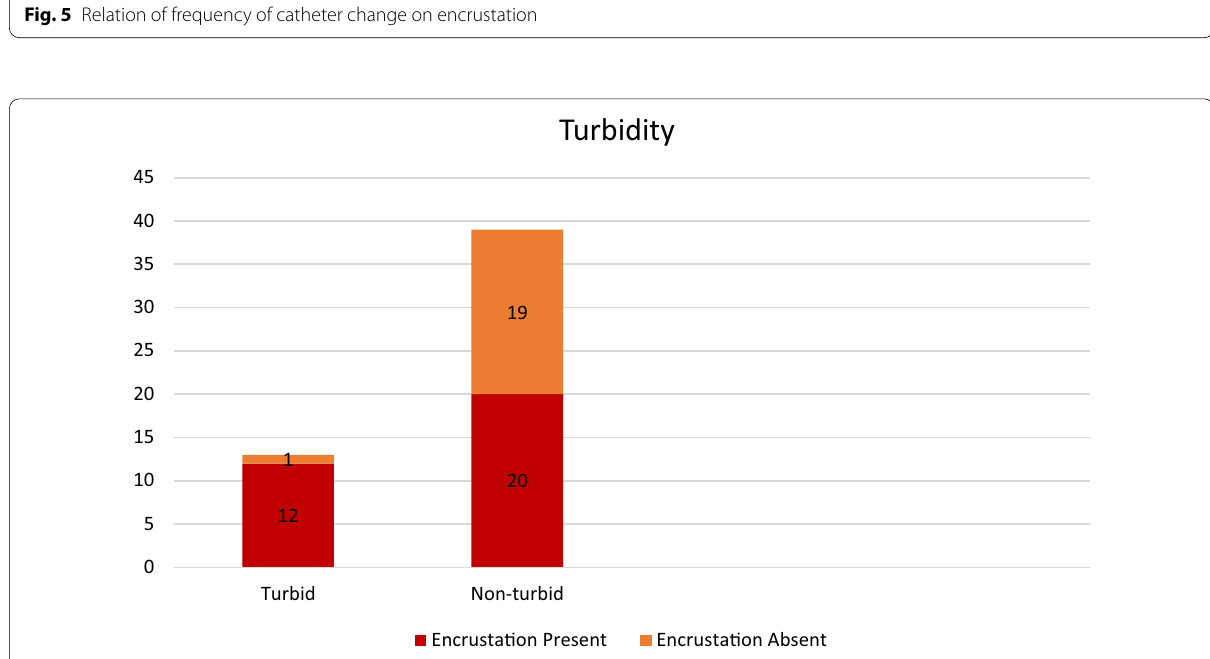
Fig. 6 Relation of urine turbidity and catheter